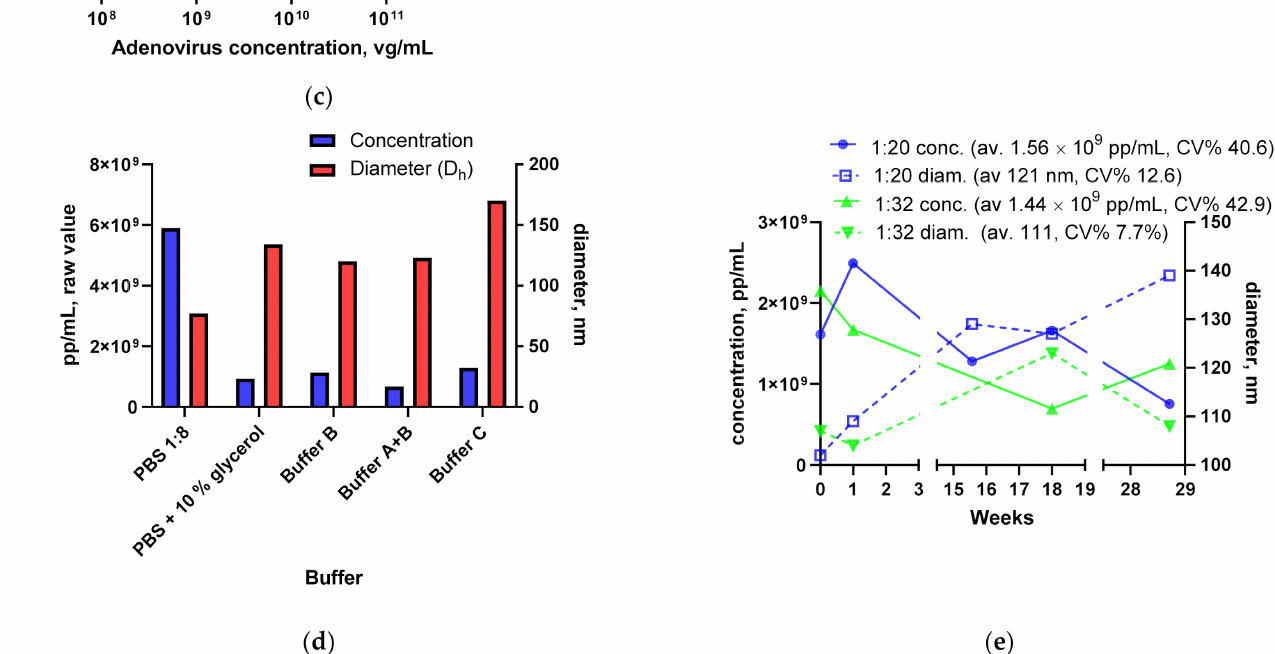
Figure 3. Blank-corrected Videodrop BV and Ad measurement results: ( a ) clarified BV sample dilutions (PBS) were measured using the standard setting (threshold 4.2) and reduced threshold values (3.8 and 3.4). Blank-subtracted values were compared to the ddPCR vg/mL titer (titered from the undiluted sample). ( b ) Purified BV sample dilutions (PBS) were measured using threshold values 3.8 and 3.5. ( c ) Adenovirus dilution series was measured using different detection threshold values. Raw values and the dilution-corrected value for TH 3.2 are shown. Dotted line shows the upper raw value concentration limit set for the manufacturer for the visual threshold adjustment method. The solid blue line shows the virus genome titer. Correlation coefficients between the vg/mL and pp/mL concentrations shown in the legend. ( d ) Adenovirus samples (6.85 × 10 10 vp/mL) diluted in different buffers. Buffer A and B are Ad chromatography buffers, and buffer C is a formulation buffer. ( e ) Repeatability results (raw values, TH 3.5) for an Ad sample (separate aliquots) measured over several